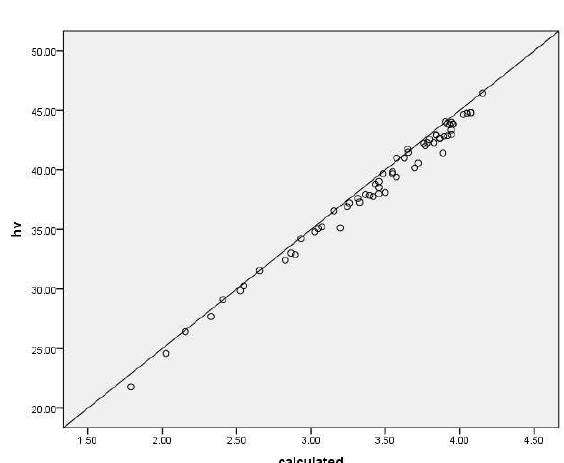
Figure 3: Correlation of E D